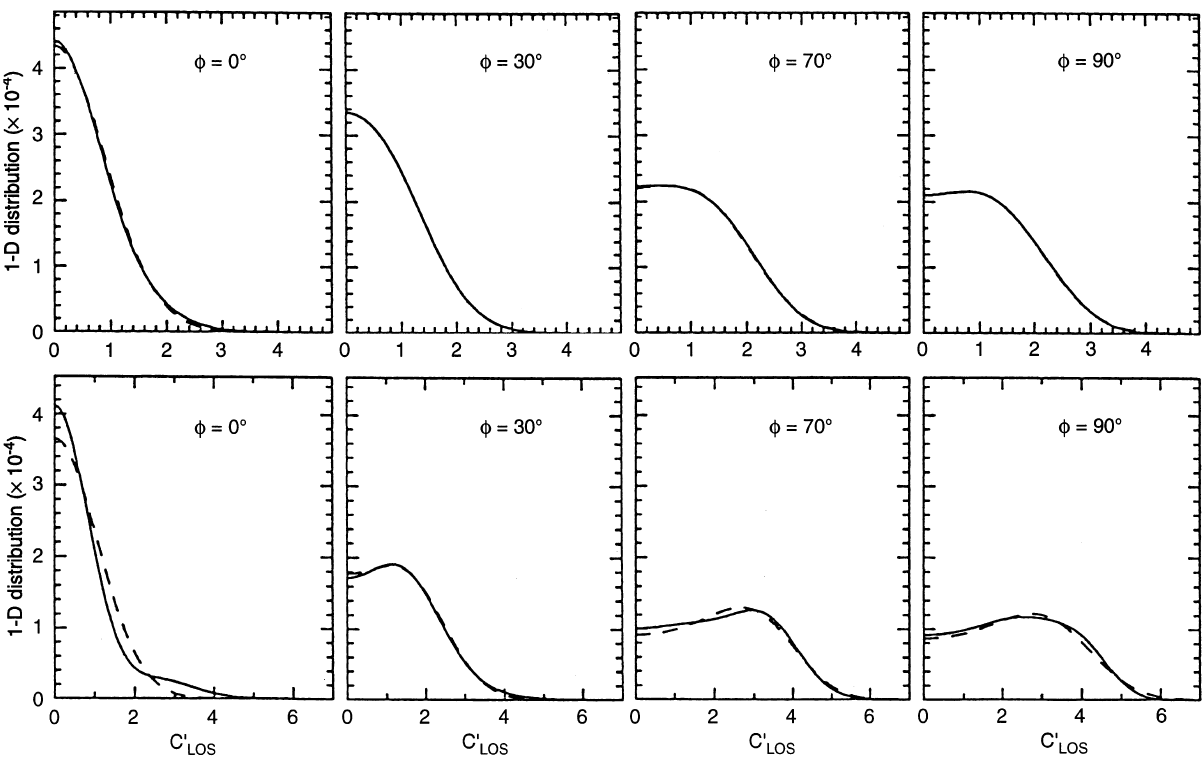
Fig. 5. The top panels show ( solid line ) the 1-D distribution for an electric field intensity of 100 mV/m and four angles-of-sight of 0 (cid:14) ; 30 (cid:14) ; 70 (cid:14) ; 90 (cid:14) from left to right . The dashed curves represent the fitted 1-D Raman distribution. The four lower panels show similar results for an electric field intensity of